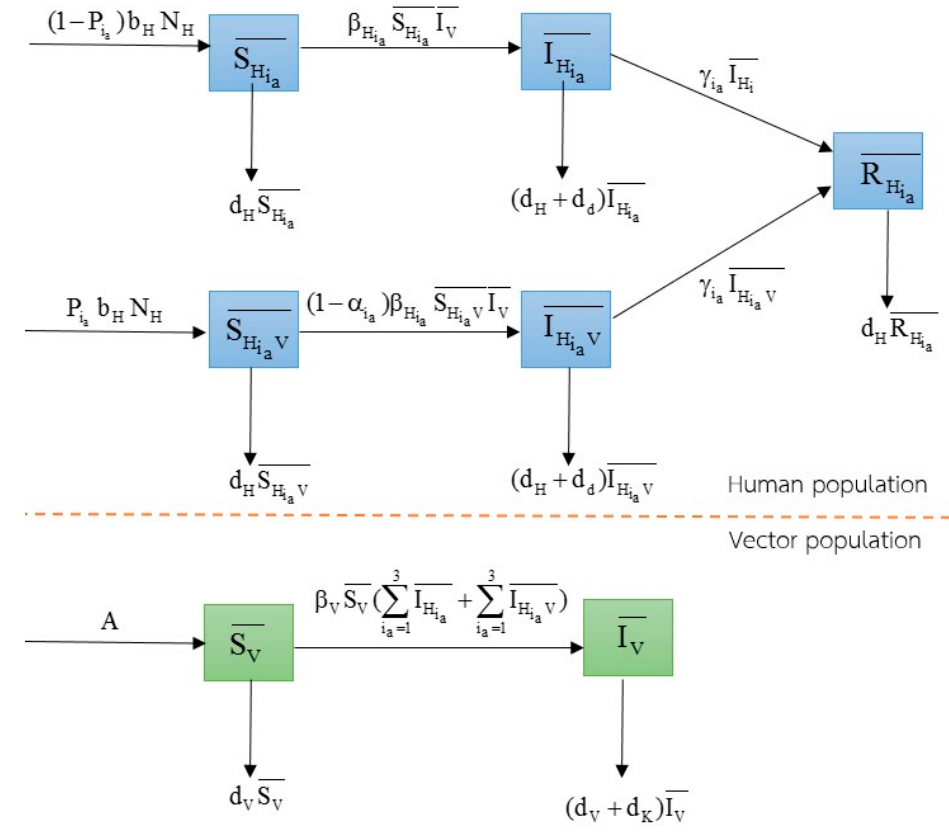
Figure 3. Diagram of dengue disease with vaccination model.